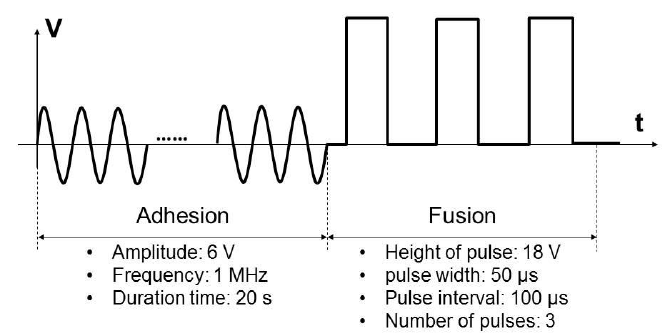
Figure 4. Schematic diagram of the electrical stimulation pulses for fusion between cells and giant liposomes. After introducing the suspension in the microchannel, first an AC voltage (6 V; 1 MHz; 20 s) and then a DC voltage (18 V; pulse width, 50 μs; pulse interval, 100 μs; number of pulses, 3) were consecutively applied.